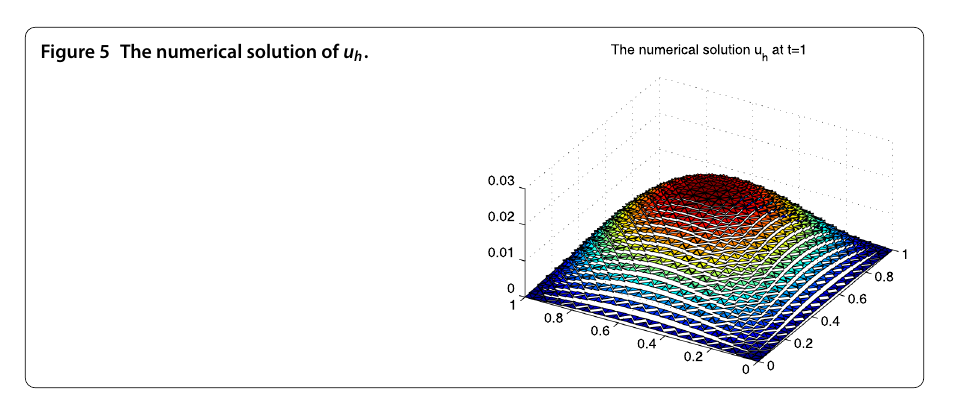
Figure 5 The numerical solution of u h .